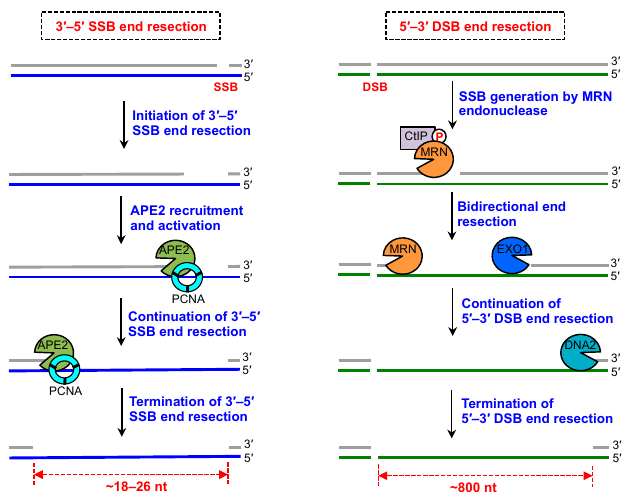
Figure 3. SSB end resection and DSB end resection. Left panel shows molecular details of 3 ′ –5 ′ SSB